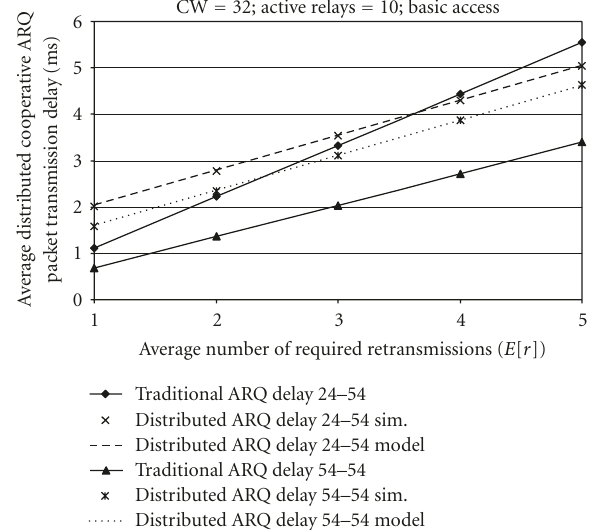
Figure 7: Average distributed cooperative ARQ packet transmission delay as a function of the transmission rates (relay high-rate